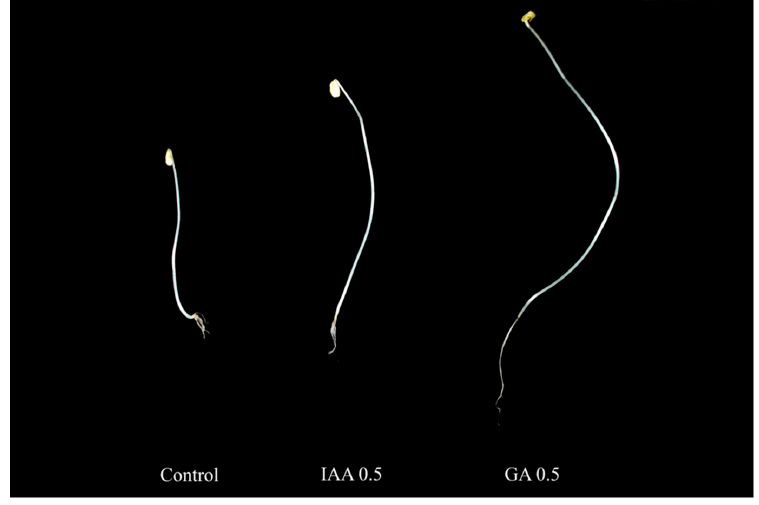
Figure 1. Effect of indole-3-acetic (IAA) and gibberellic acid (GA) on sprout growth. Table 1. Morphological differentiation in common buckwheat sprouts treated with exogenous hormones at different concentrations. Data were recorded after 10 days of growth.